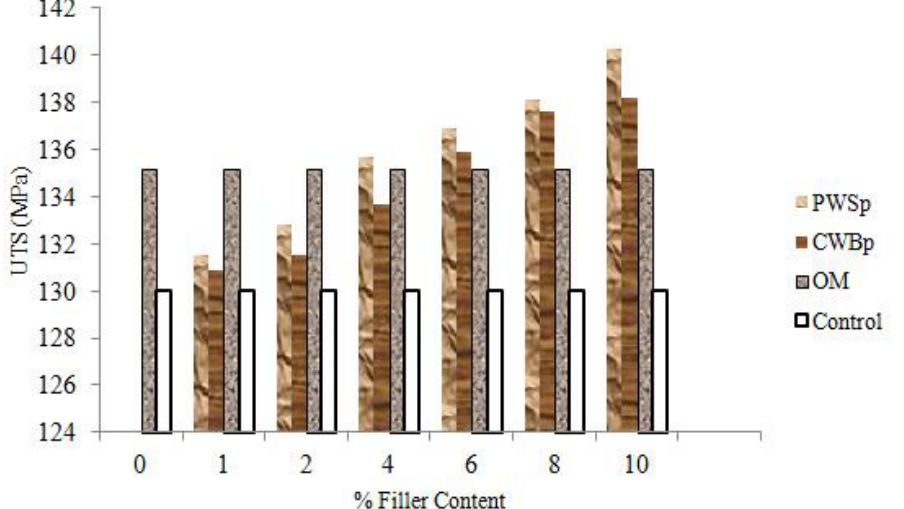
Figure 7: Tensile strength of Al/Ps and Al/Cb with control and